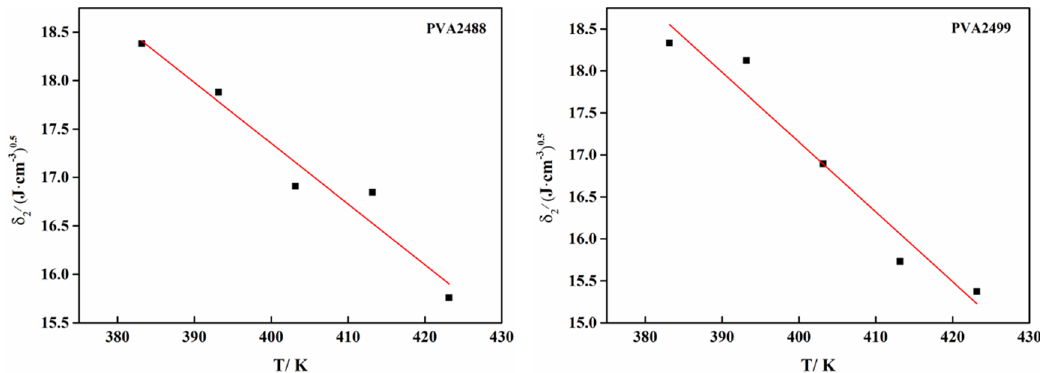
(cid:3117)(cid:3118) (cid:3117)(cid:3118)(cid:3246) − (cid:2983) Figure 2. (cid:2964) and δ (cid:2869) curves of PVA at different temperatures. (cid:2902)(cid:2904) (cid:2906) (cid:3117)